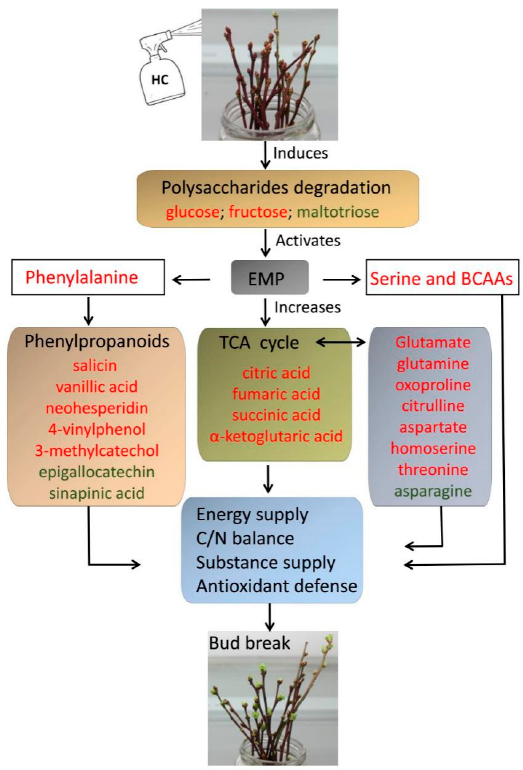
Figure 4. Schematic representation of the mechanisms of blueberry bud break after HC treatment. Red/green indicates metabolites whose relative content increases/decreases after HC treatment compared with CK.